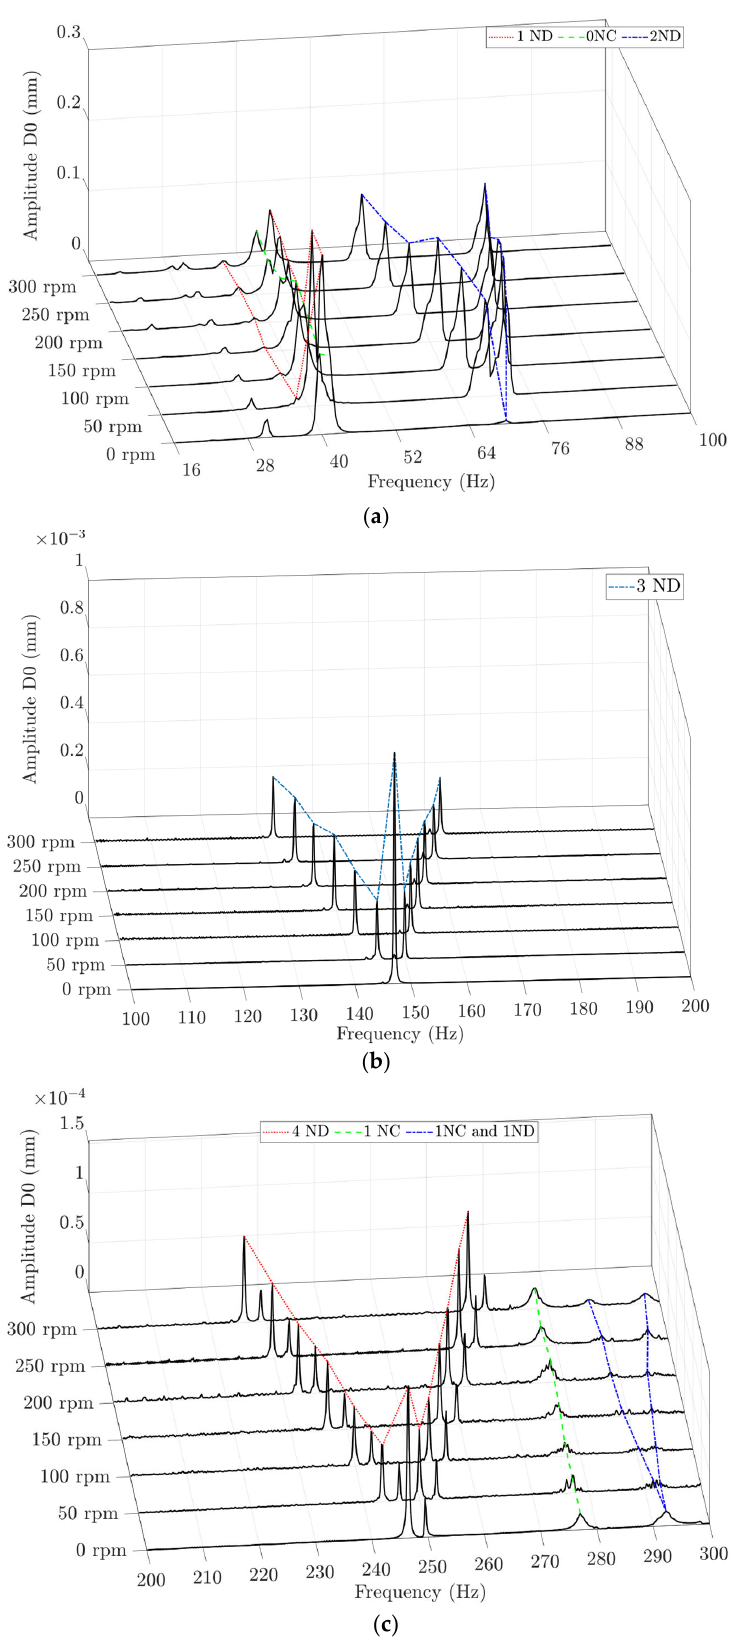
Figure 13. ( a ) Maximum spectra of the STFT of the D0 when the disk was excited with chirps in air in the ranges of 0 to 100 Hz ( a ), 100 to 200 Hz ( b ) and 200 to 300 Hz ( c ) at different rotating speeds. Figure 14 shows the spectra in the range of 200 to 320 Hz measured by the off ‐ board accelerometer mounted on the upper bearing in the radial direction, AUB y , at different rotating speeds. The spectrum at 0 rpm presented three frequency peaks corresponding to the 4ND at 246.5 Hz, the 1NC at 277.1 Hz and the 1NC+1ND at 292.3 Hz. When the rotating speed was increased, the single frequency peak corresponding to the 4ND was split into two frequency peaks: one with a higher value and the other with a lower value. The higher and lower frequencies increased and decreased, respectively, when the rotat ‐ ing speed of the disk increased. On the other hand, the single frequency peak correspond ‐ ing to 1NC was not split, and it always presented the same frequency value. Finally, the 1NC+1ND mode shape divided into three frequency peaks when the disk rotated: one with a higher value, another with a lower value and the last one with the same frequency value. The higher and lower frequencies increased and decreased, respectively, when the rotating speed of the disk increased. The third frequency presented the same value at dif ‐ ferent rotating speeds. The 1NC+1ND was therefore transmitted to the bearing housing partially like an ND mode and partially like an NC mode. Roig et al. [35] also observed that the axial vibration of a rotating rotor is transmitted from the rotor to the supporting structure at the same frequency. Unlike to the transmission equation of D0 see Equation (1), in this case, the natural frequency detected by the accelerometer, 𝑓 (cid:3028)(cid:3030)(cid:3030) , of an ND mode only depended on the 𝜔 (cid:3045)(cid:3042)(cid:3047) based on the following expression: 𝑓 (cid:3028)(cid:3030)(cid:3030) (cid:3404) 𝑓 (cid:3042)(cid:3041)(cid:2879)(cid:3029)(cid:3042)(cid:3028)(cid:3045)(cid:3031) (cid:3399) 𝜔 (cid:3045)(cid:3042)(cid:3047) (2) These results indicate that the positions of the sensors had a great impact on the nat ‐ ural frequency detected when the disk was rotating. The detected natural frequency strongly depended on the reference frame of the sensor and if the sensor was able to meas ‐ ure displacements of the disk directly or remote vibrations on a bearing housing.